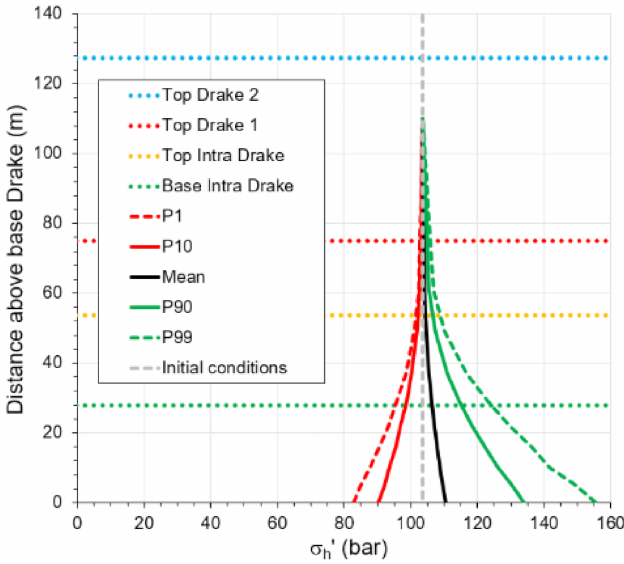
Figure 5. Potential effective stress profiles versus distance above base Drake/top Cook, after 25 years of